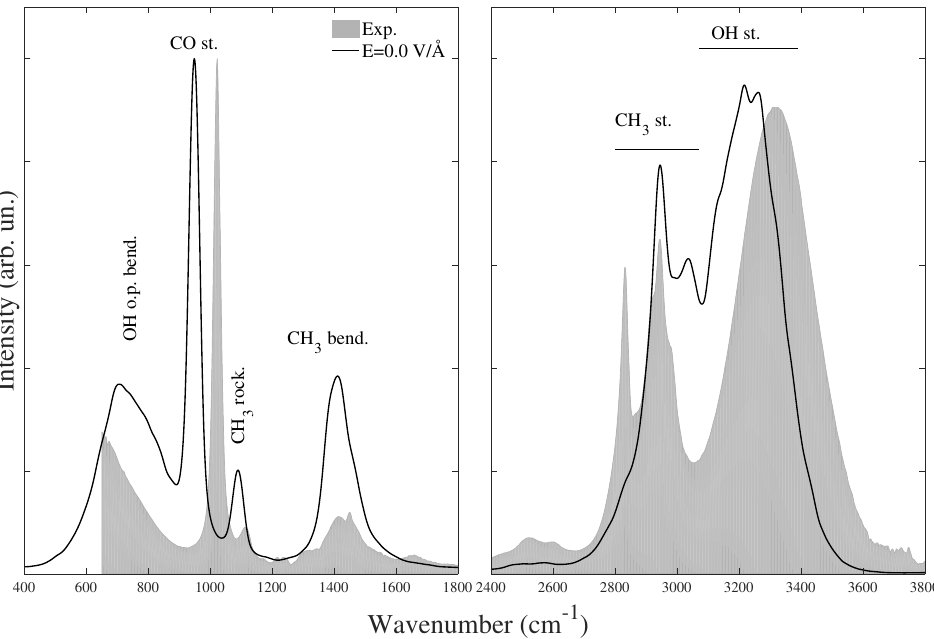
Figure 1. Infrared (IR) absorption spectra of liquid methanol determined from AIMD simulation (black line) at room temperature and in absence of electric field. The experimental results [76] are shown as gray shading for reference. In the two panels, the intensities of the highest peaks are rigidly scaled for better comparison between computations and